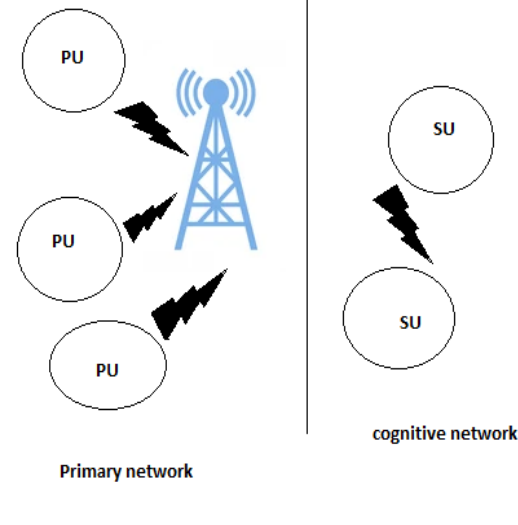
Fig 2 Illustration of Spectrum